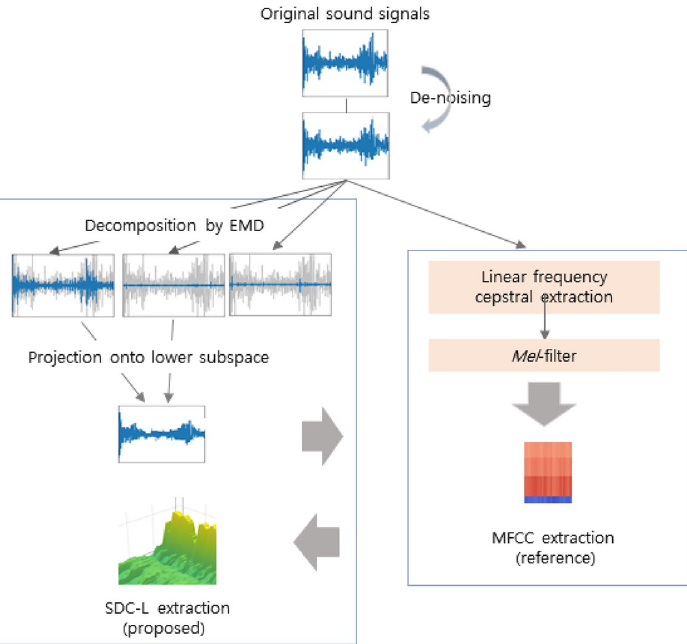
Figure 1. Block diagram of feature